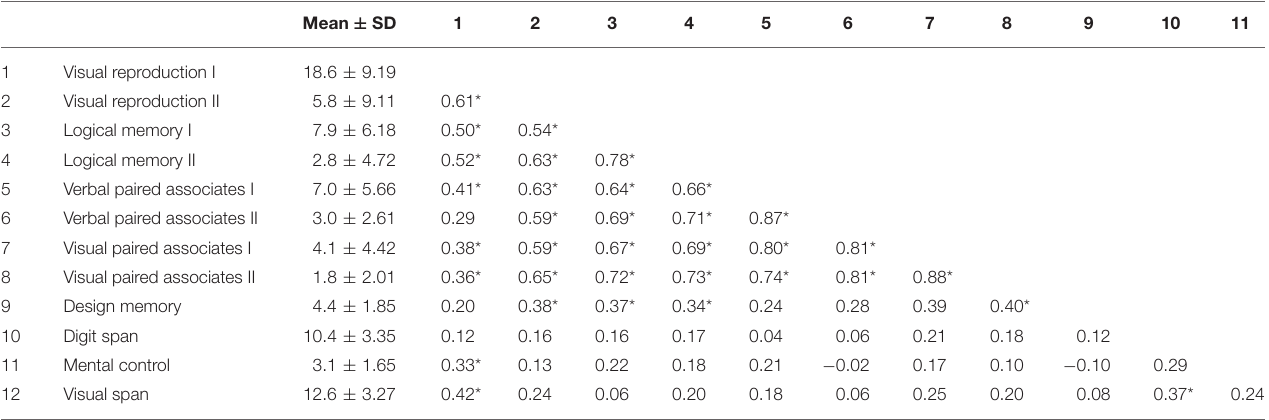
TABLE 1 | Inter-Correlation Matrix for the WMS-R Subtests.